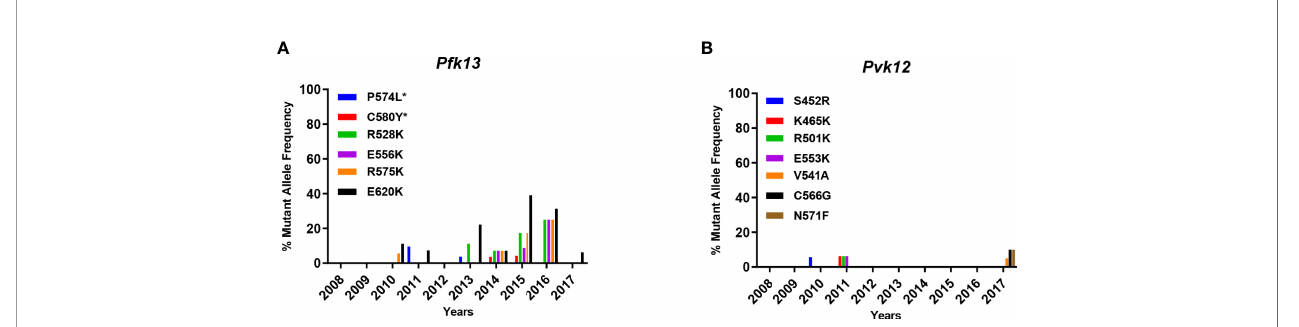
FIGURE 2 | Mutant locus frequency and distribution of pfk13 and pvk12 . (A, B) Histogram analysis for pfk13 and pvk12 in Table 1 , respectively. The star indicates the loci associated with artemisinin